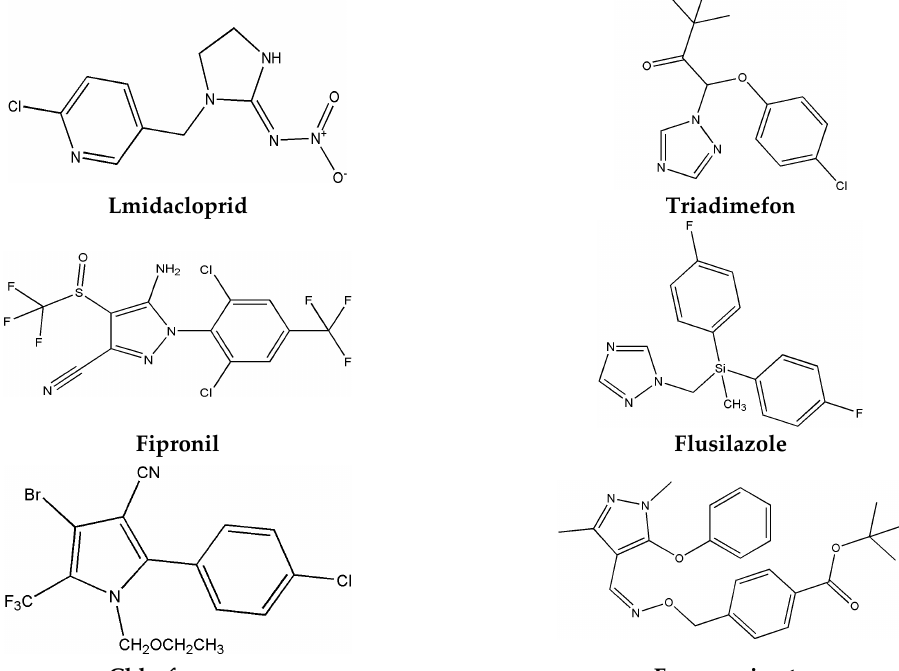
Figure 1. Structural formula of six heterocyclic pesticides.